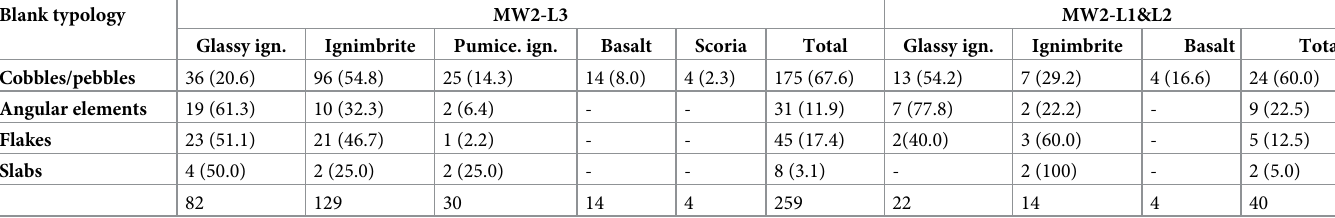
Table 3. Absolute and relative frequencies (in parentheses) of core blank typologies (per raw materials) exploited by occupants of MW2. Blank typology Glassy